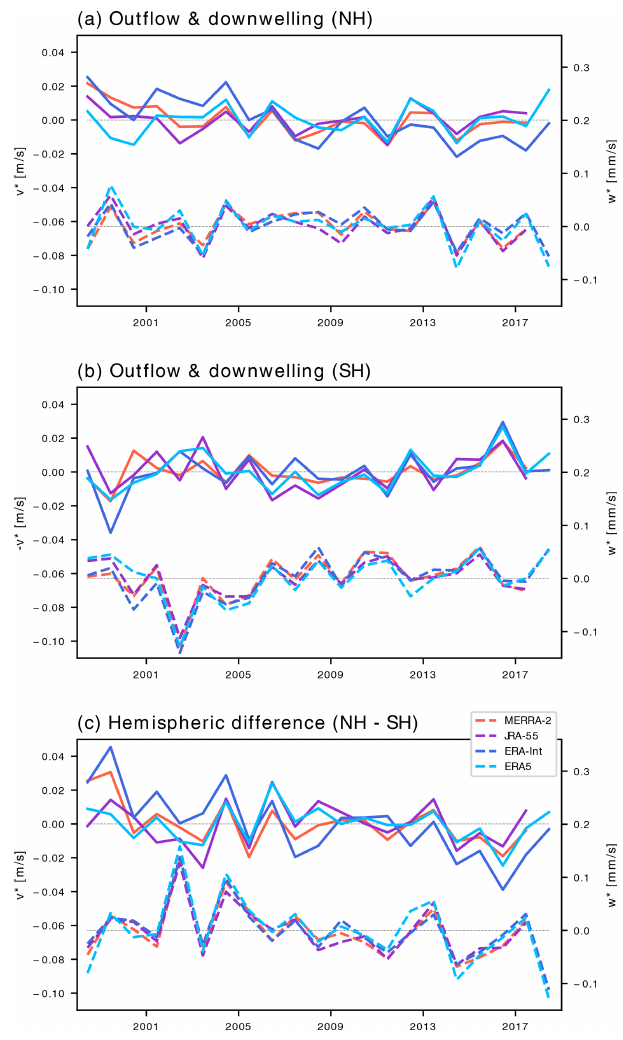
Figure 5. Indices for shallow and deep BDC branches for (a) the NH and (b) SH and (c) the hemispheric difference (NH − SH), cal- culated as deseasonalized, annually averaged time series of hori- zontal residual-circulation outflow velocity v ∗ averaged over 20– 25km at turnaround latitudes (solid lines) and vertical velocity w ∗ averaged over 50–80 ◦ latitude at about 25km (dashed). Different colours show different reanalysis data sets. Note that SH outflow velocities are shown with a reversed sign ( − v ∗ ) such that positive velocity corresponds to stronger outflow out of the tropics in both